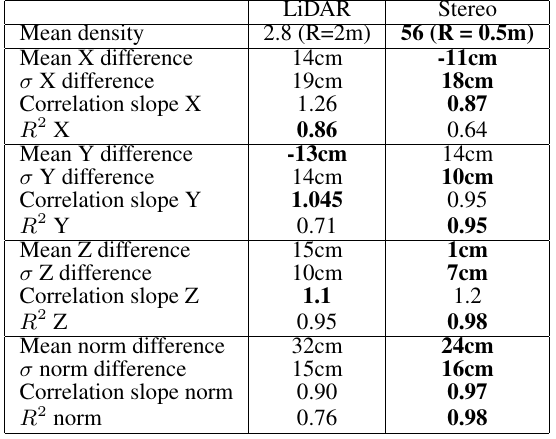
Table 1. Comparison between GPS velocity measurements (14 rocks measured during field campaign the 18/10/2018 and the 10/09/2019) and velocity obtained from DEM (from LiDAR) correlation and by our methods. For each GPS measurements (each rock), neighbor vectors (radius 0.5m for stereo and 2m for LiDAR) are extracted from LiDAR and stereo field and a median filter is apply to be directly compared with the GPS measurements. Then mean, standard deviation σ , correlation slope, and R squared value are extracted for each dimension.